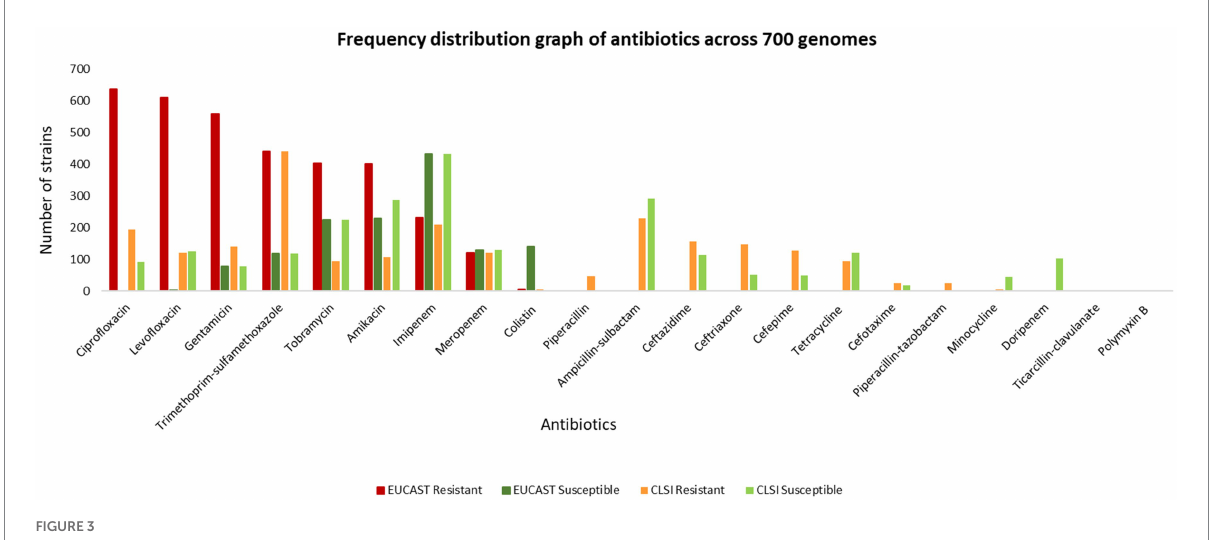
FIGURE 3 Frequency distribution graph of antibiotics across 700